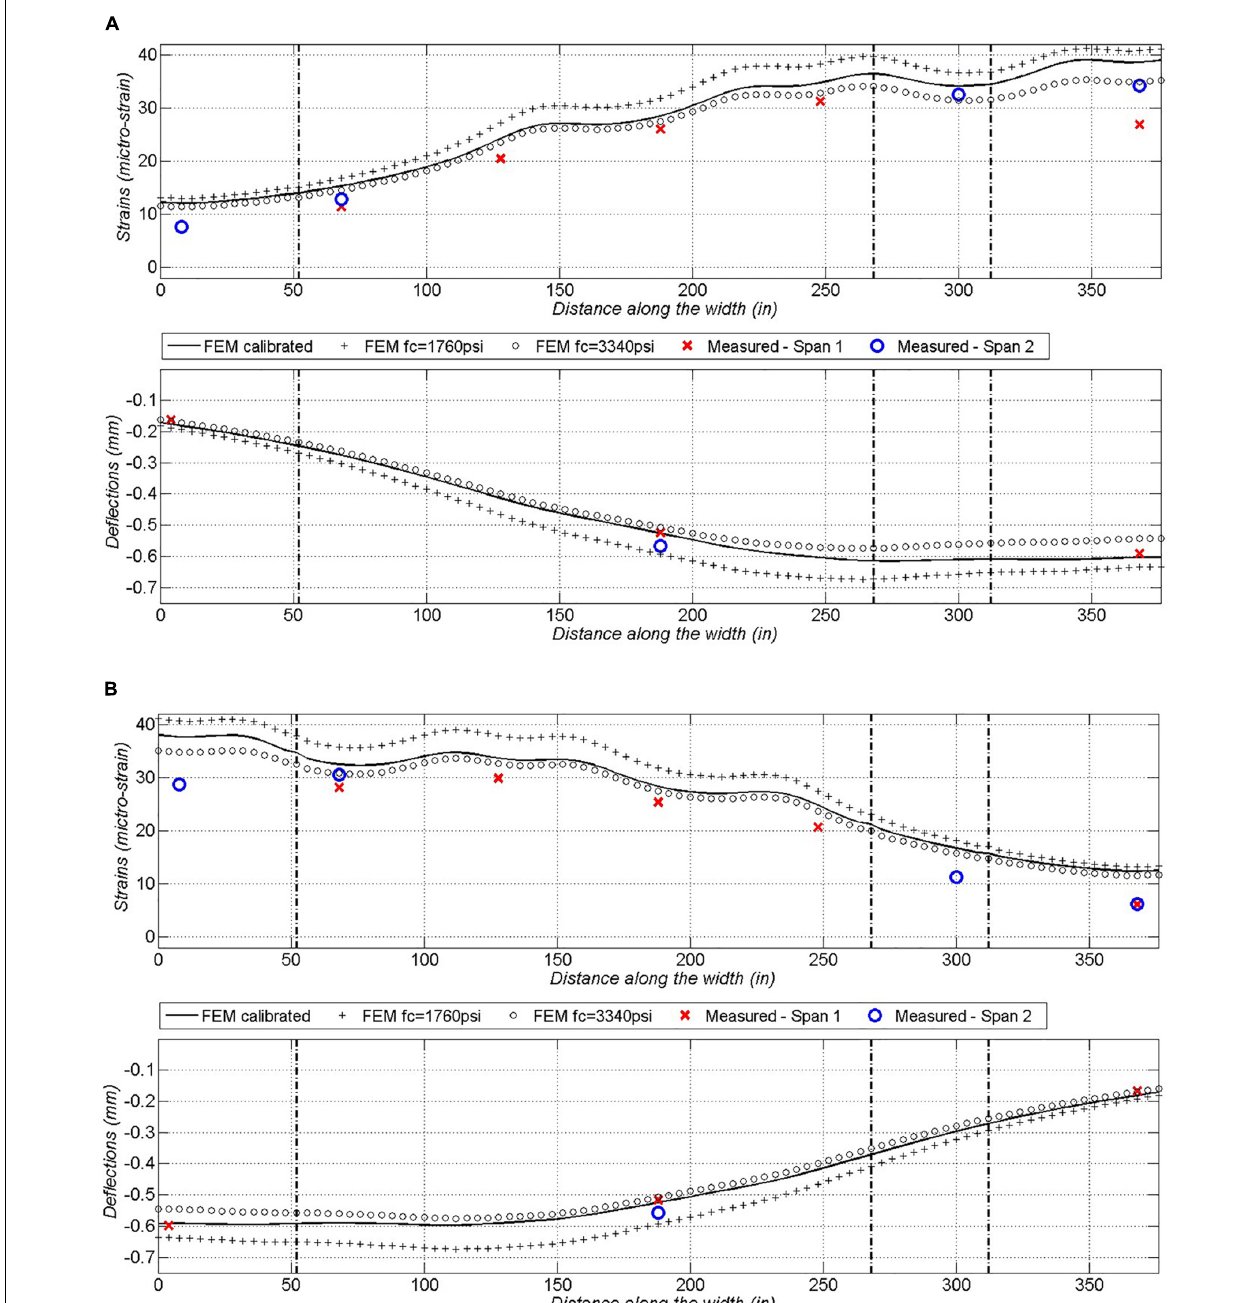
FIGURE 9 | Comparison plot of strains and deflections for (A) LP-4-R, (B) LP-4-L (1 inch = 25.4 mm, 1 mm = 0.02 inch).